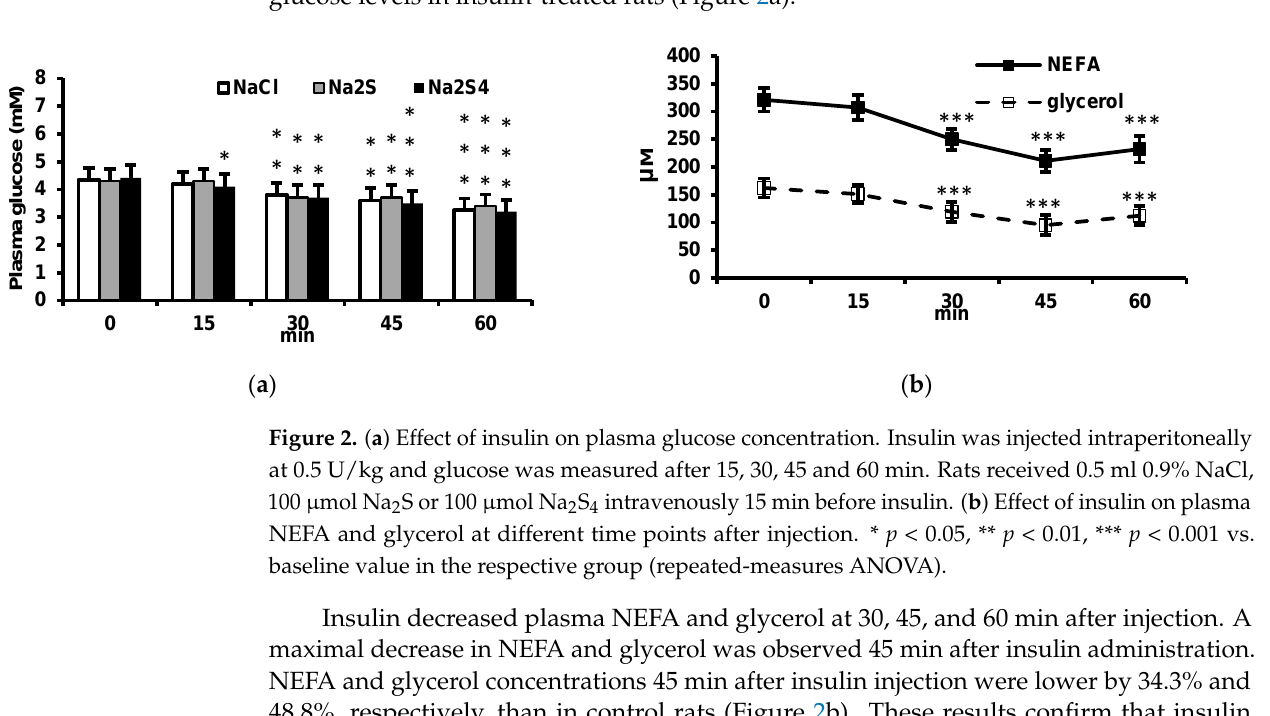
Figure 1. Effect of Na 2 S and Na 2 S 4 on plasma glucose ( a ) and insulin ( b ) concentrations. Na 2 S or Na 2 S 4 were injected intravenously and blood samples were collected before as well as 15, 30, 45, and 60 min after injection.